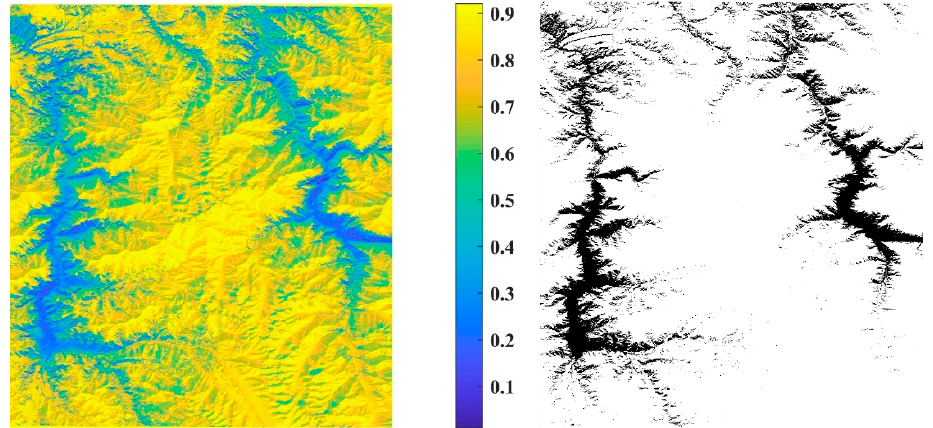
Figure 6. Normalized Difference Snow Index (NDSI) and the corresponding snow cover area (SCA).